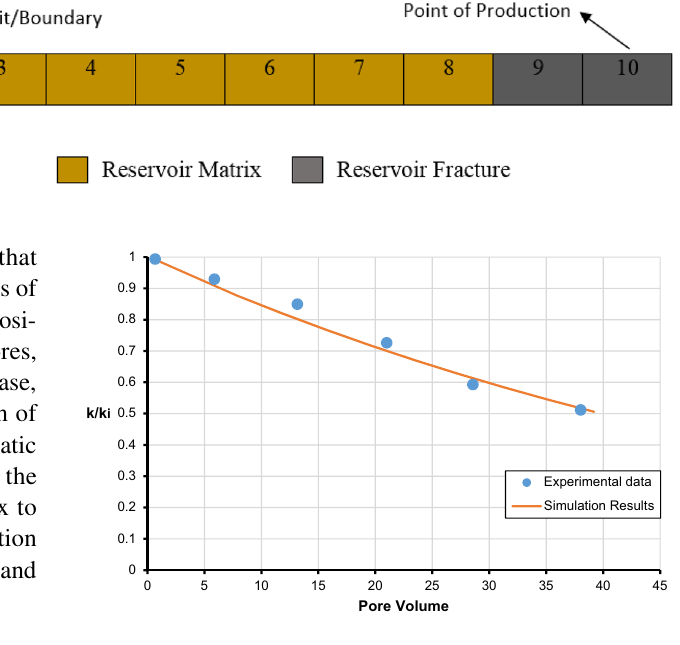
Fig. 5 Comparison of results with experimental data from Soulgani et al.